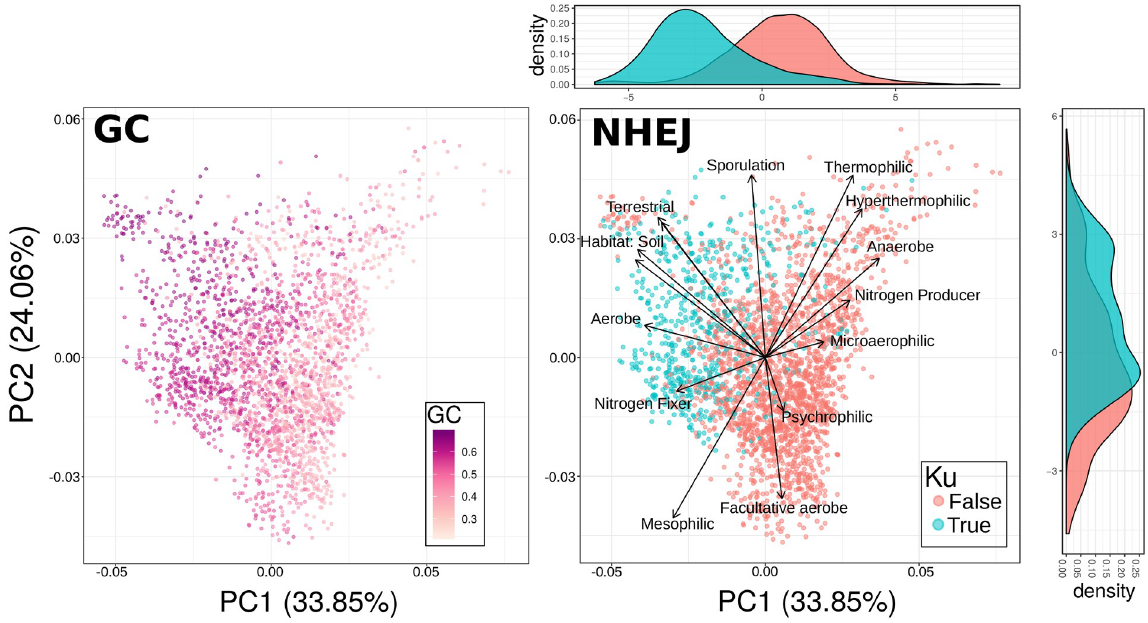
Fig 1. Ku and high GC content share a particular region of trait space. PCA of microbial trait data for select traits with species colored based on either their mean genomic GC content or whether they have known members that encode the Ku protein. Trait loadings signified by arrows. Note the clear separation of Ku and no-Ku organisms in trait space.